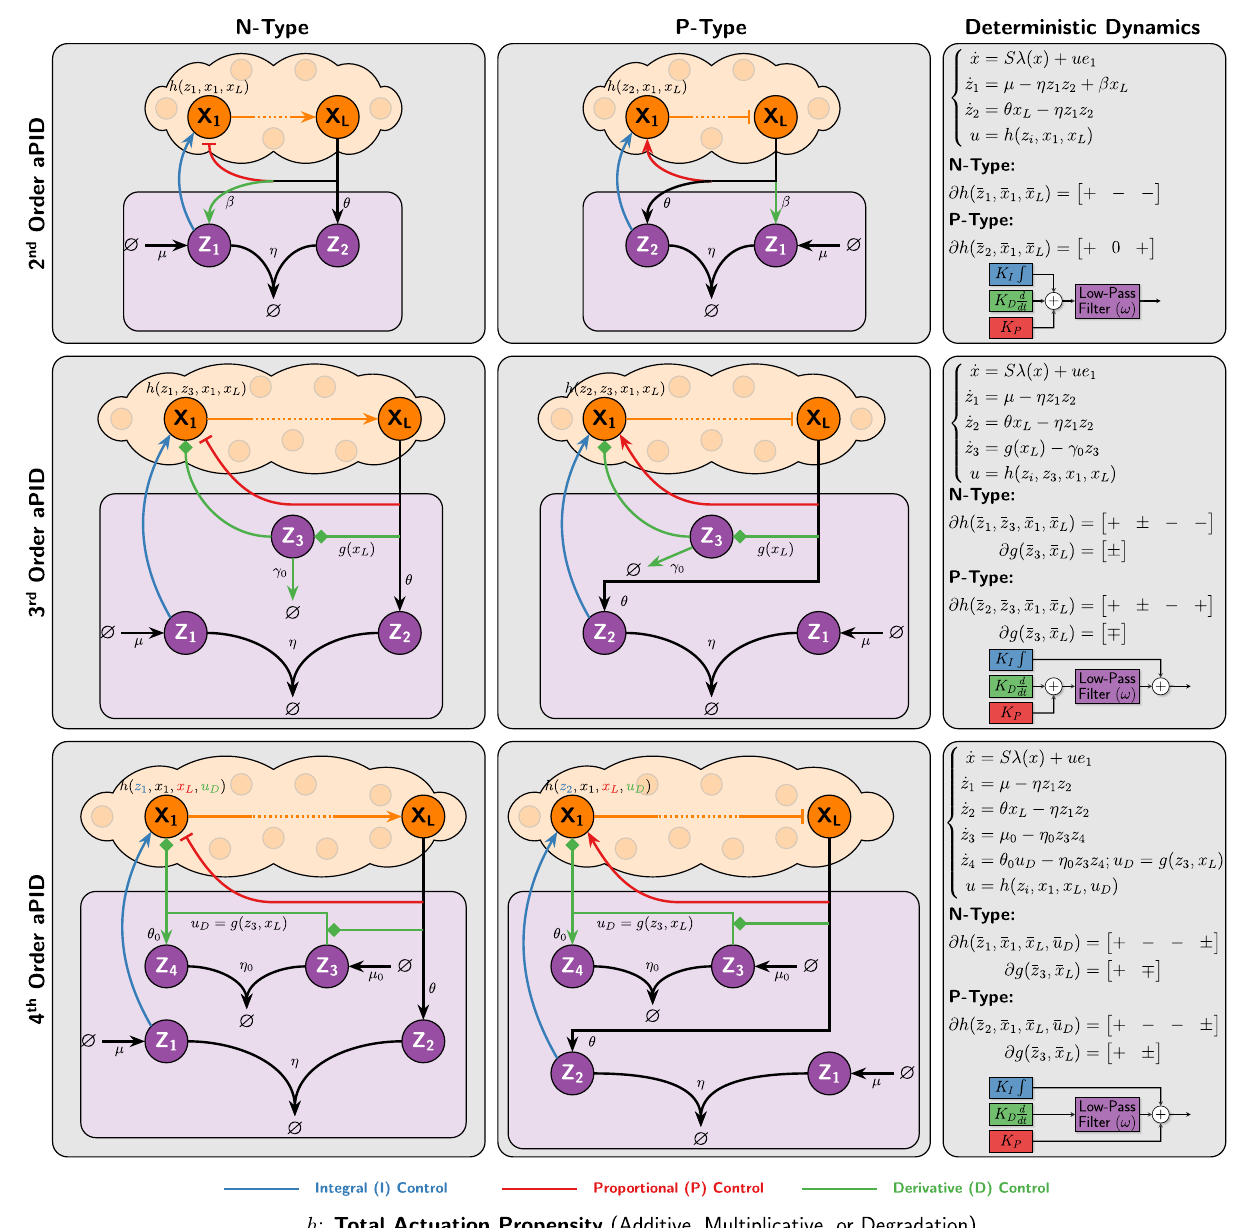
Fig. 5 Antithetic proportional-integral-derivative ( a PID) feedback controllers. N-type (negative feedback) controllers are usually suitable for plants with positive gain (increasing the input yields an increase in the output), while P-type (positive feedback) controllers are usually suitable for plants with negative gains. The order of the controllers indicates the number of controller species Z i . The second-order a PID controller has the simplest design where no additional species are added to the a PI design, and only one reaction is added to produce Z 1 catalytically from the output X L at a rate β < θ . The third-order a PID controller adds a single species to the a PI design. This intermediate species Z 3 is produced by the output X L and actuates the input species X 1 . These actions (indicated by the diamonds) are allowed to be either activations or inhibitions. Finally, the fourth-order a PID controller adds two species to the a PI design. These two species form an “ antithetic differentiator ” where Z 3 is constitutively produced at a rate μ 0 and participates with Z 4 in a sequestration reaction with a rate η 0 . For the N-type design, the derivative action enters the plant either by mutually producing Z 4 and X 1 at a rate proportional to g ( z 3 , x L ) (see Supplementary Fig. 4) such that g is monotonically increasing (resp. decreasing) in z 3 (resp. x L ), or by producing Z 4 while degrading X 1 at a rate proportional to g ( z 3 , x L ) (see Supplementary Fig. 5) such that g is monotonically increasing in both z 3 and x L . Intuitively, the second and third-order a PID controllers mathematically realize a derivative action using an incoherent feedforward loop from the output X L to the input X 1 via Z 1 and Z 3 , respectively, whereas the fourth-order a PID controller realizes a derivative action by placing an additional antithetic integral motif in feedback with the plant and itself ( Z 3 feeds back into Z 4 the a PI controller; however, the performance is also limited and pictorially demonstrated in Fig. 6c for each a PID controller. How- cannot be made faster than a threshold, dictated by γ 1 and γ 2 , ever, it is shown in Supplementary Information Section 5.2 that the second-order a PID imposes a lower bound on the achievable poles without causing overshoots and/or oscillations. In contrast, it is also ffiffiffi p shown in Supplementary Information Section 5.2 that the third- and Þ γ 1 þ γ 2 as demonstrated in Fig. 6c. As a result, given by (cid:3)ð 2 þ 2 2 fourth-order a PID controllers can make a as large as desired without with a second-order a PID, the performance can be made better than